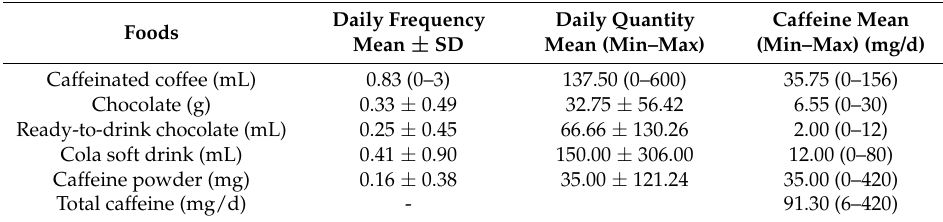
Table 3. Food frequency and quantity of caffeine from foods*.